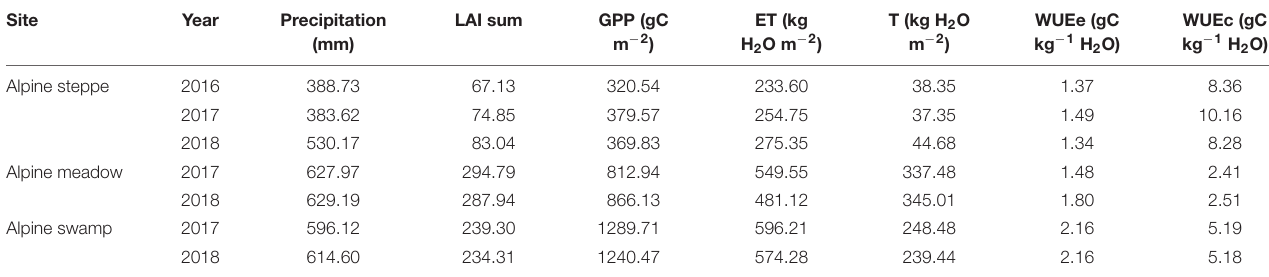
TABLE 2 | Sum of daily GPP, ET, T, and LAI during each growing season and annual WUE at the three Qinghai–Tibetan Plateau